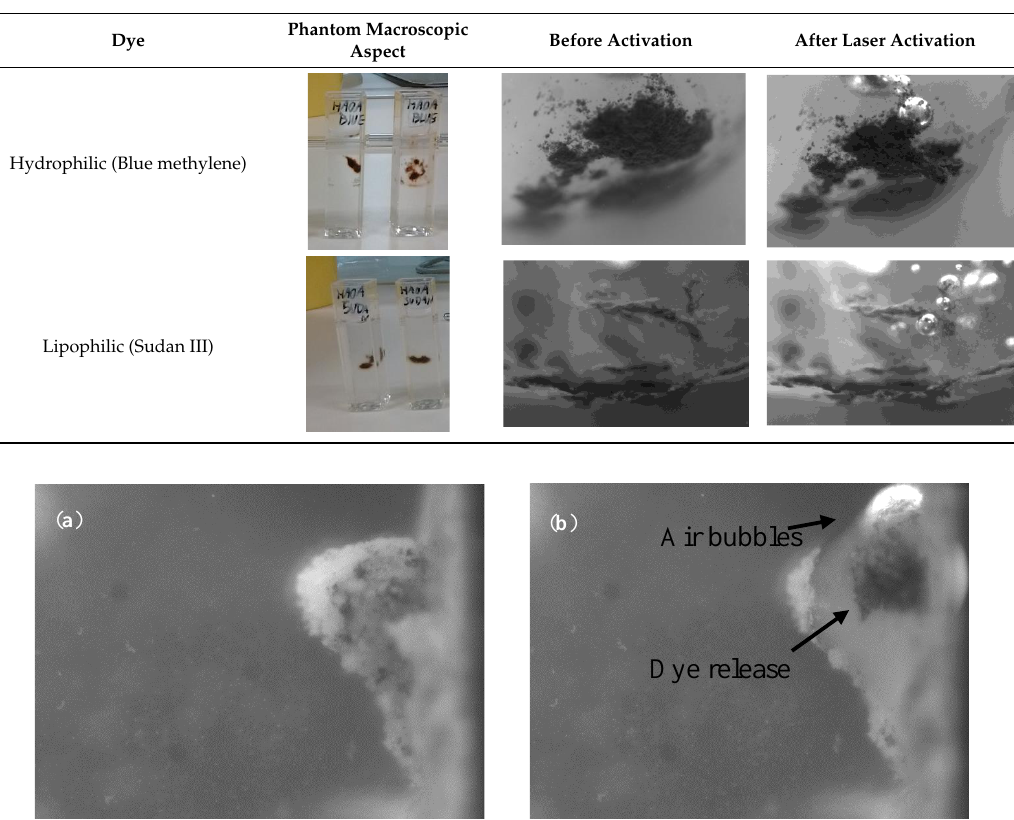
Table 4. Phantom macroscopic aspect before and after laser activation using two experimental dyes (only used in this assay).